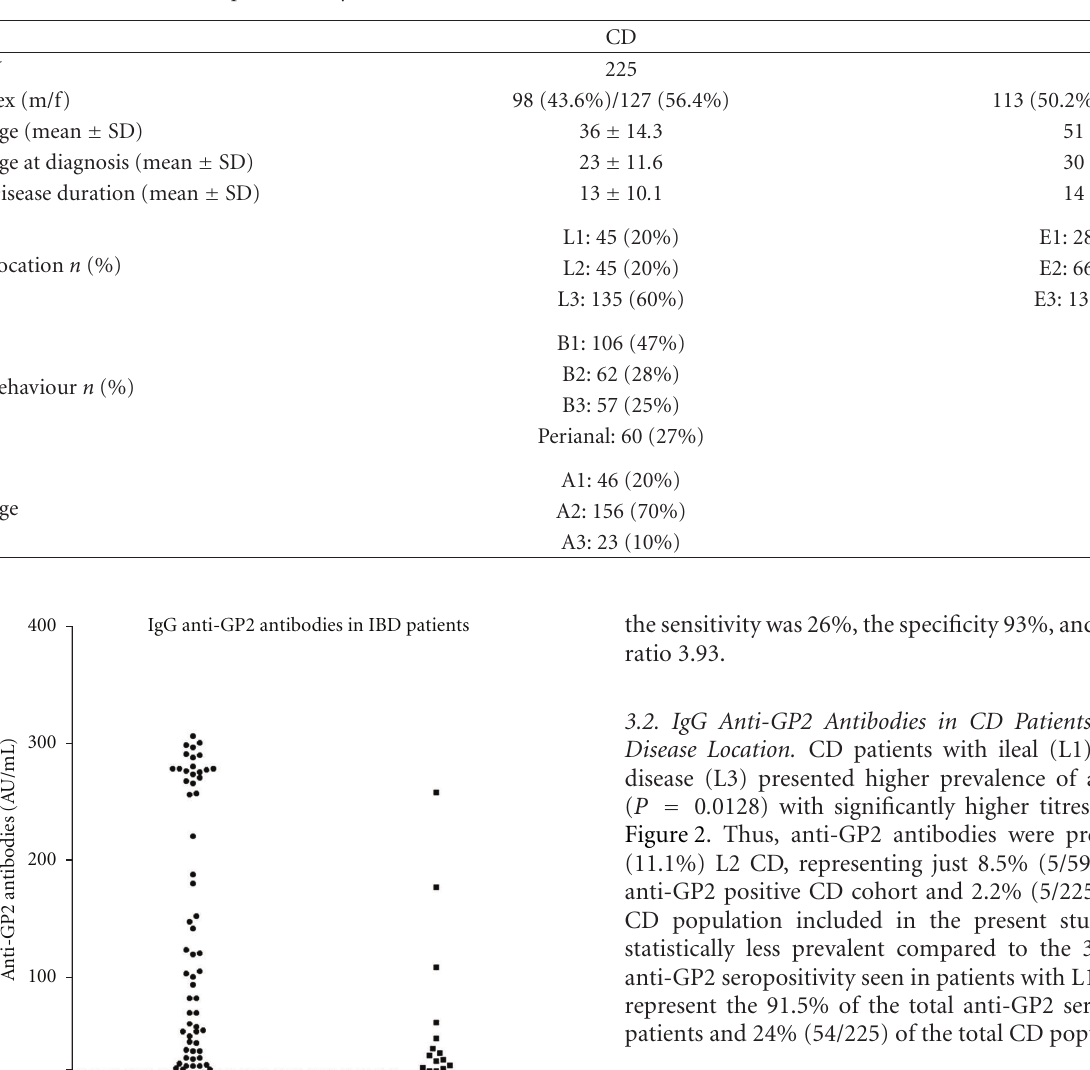
Table 1: Main demographic and clinical characteristics of the 225 patients with Crohn’s disease (CD) and the 225 patients with ulcerative colitis (UC) included in the present study.